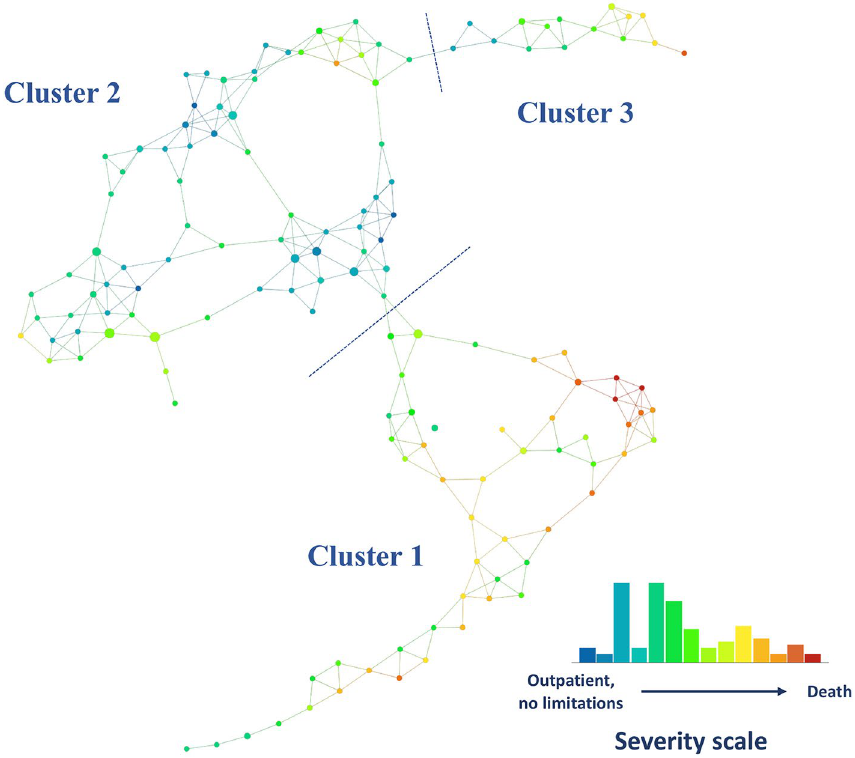
Figure 1. Topological data analysis (TDA) network of protein expression during the middle-phase of COVID- 19. Distinct protein expression phenotypes (Clusters 1, 2, and 3) were identified based on density and break points in the network and persistence of the clusters. Each node represents a combination of 12 plasma protein analyte levels and its size increases with the number of participants that are included. Edges (lines between nodes) indicate that patients are represented in more than one node. The network is colored by the average score on the disease severity scale (from outpatients without limitations [green] to death [red]) in each node. Analysis was performed on the EurekaAI Workbench (SymphonyAI, Los Altos, CA,